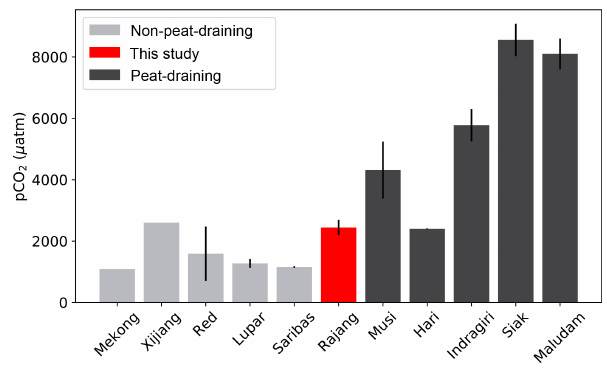
Figure 6. Comparison of average p CO 2 values in Southeast Asian rivers. Colors distinguish peat-draining rivers from nonpeat- draining rivers. The Rajang River (this study) is highlighted in